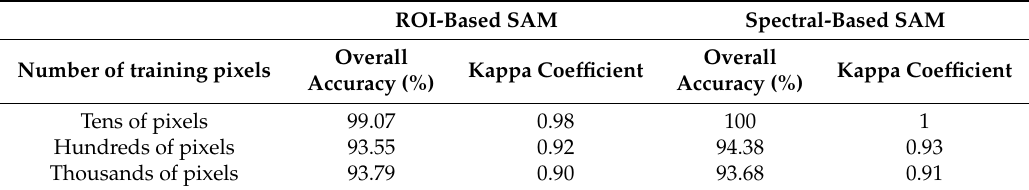
Table 1. Comparison between ROIs and ENVI-IDL © spectral-based SAM classification accuracies at different numbers of training sample pixels. Overall Accuracy (%) and Kappa coefficients.